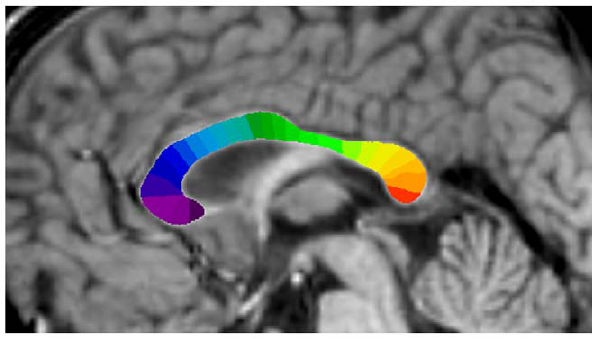
Figure 1. The midsagittal corpus callosum divided into 25 segments.